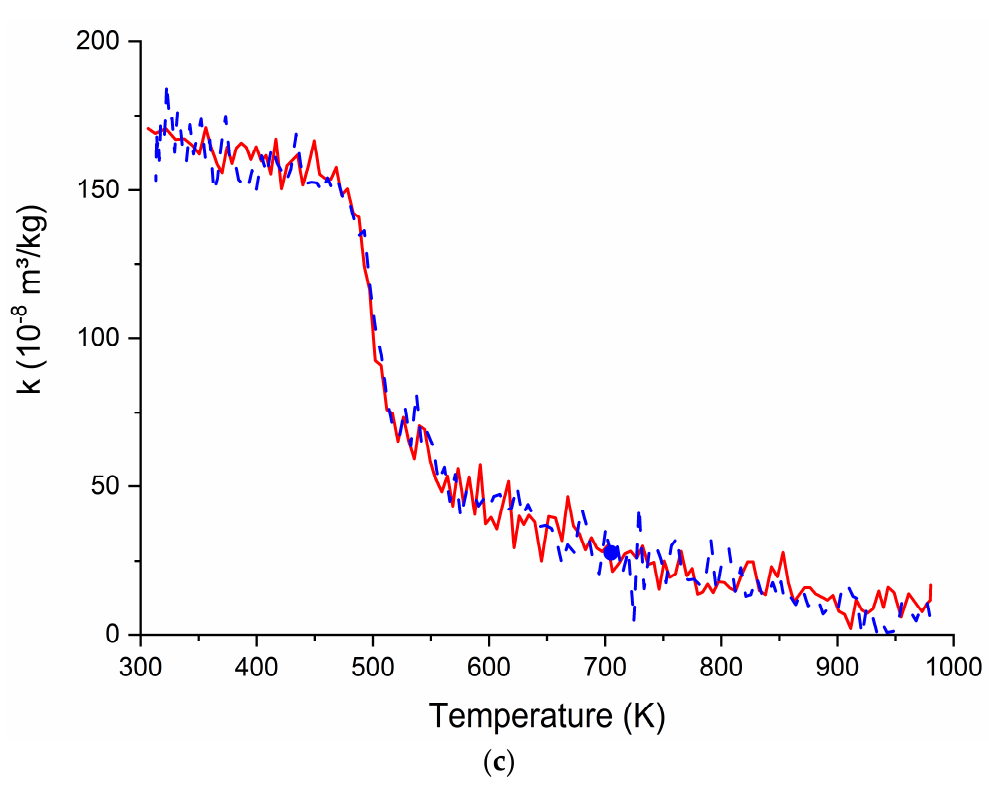
Figure 2. AC susceptibility temperature dependences: ( a ) Sample SUP; ( b ) Sample S300S-2; ( c ) Sample S300N.